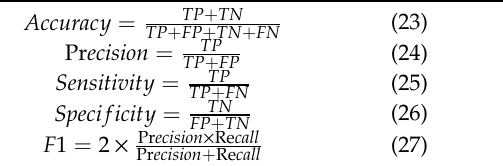
Table 4. Performance evaluation